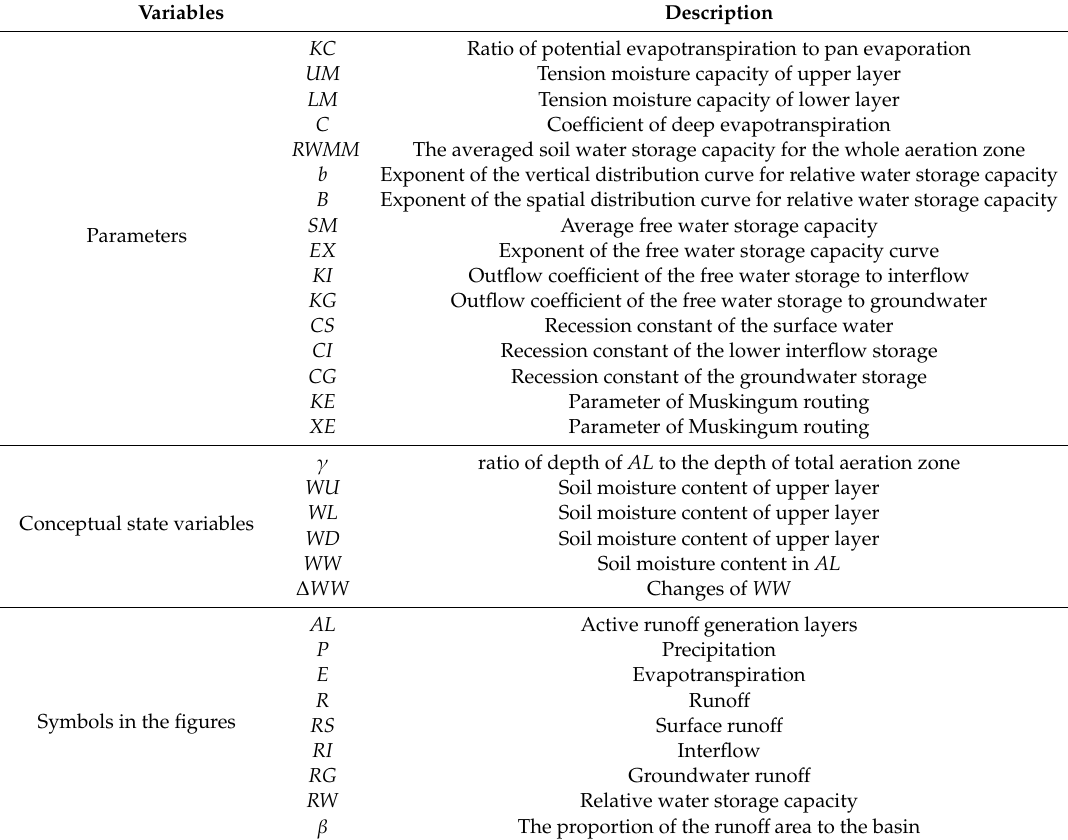
Table A1. The symbols and the definitions of the variables used in the